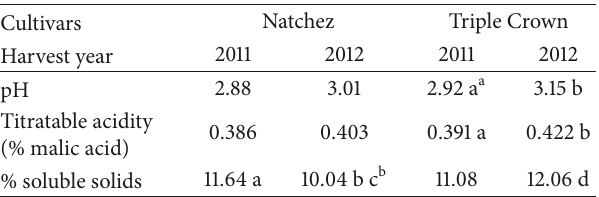
Table 1: Average mean concentration of pH, titratable acidity, and soluble solid values of pressed blackberry juice ( 𝑛 = 2